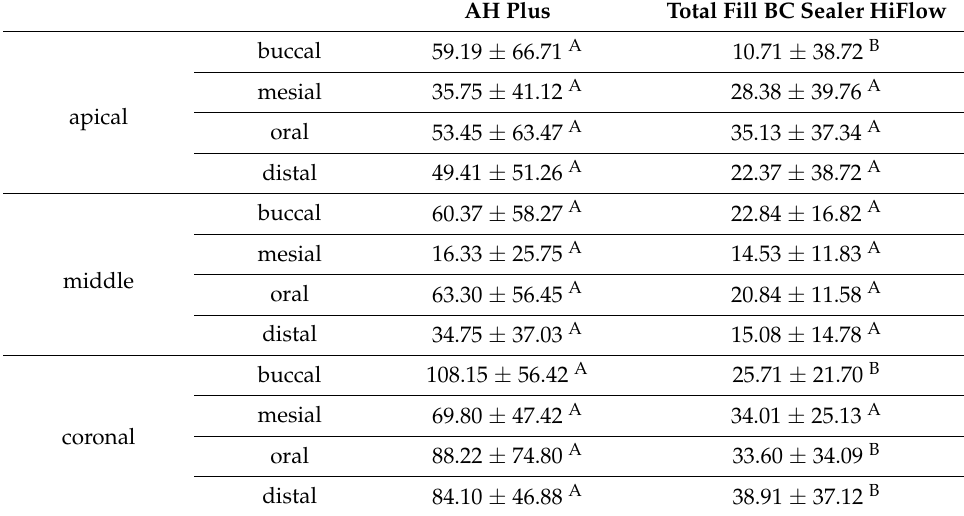
Table 2. Means and standard deviations for sealer penetration ( µ m) of AH Plus and Total Fill BC Sealer HiFlow in the apical, middle and coronal portion of the root according to the root